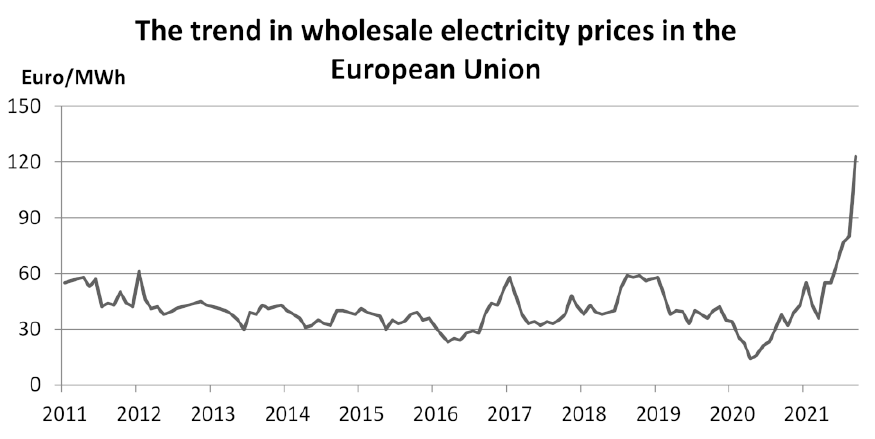
Figure 4. The trend in electricity exchange prices in the European Union from January 2011 to September 2021.